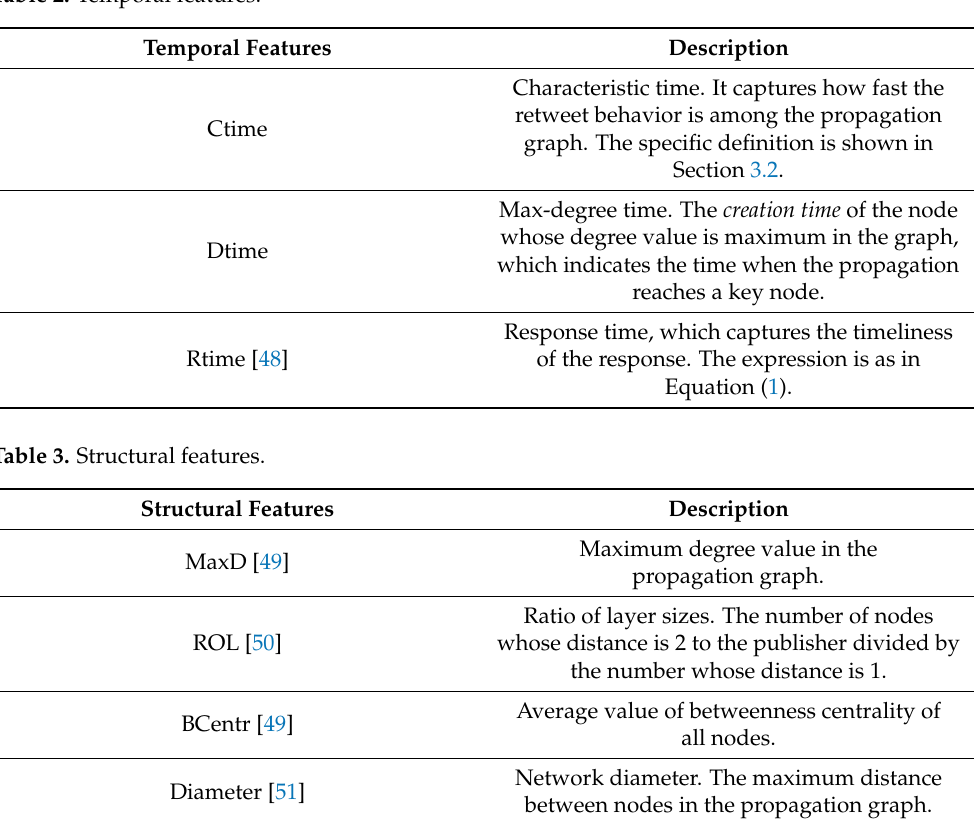
Table 2. Temporal features.